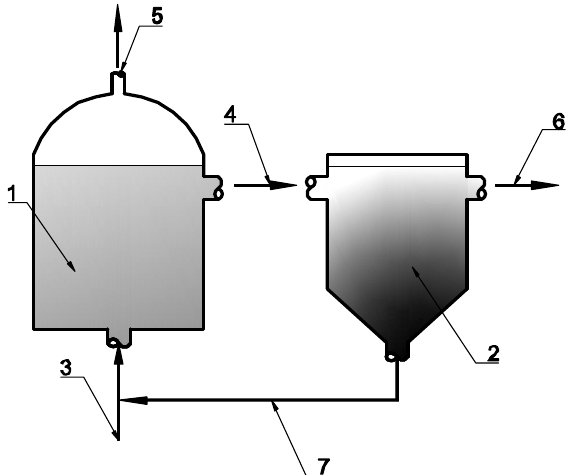
Figure 4. Diagram of a contactor: 1—reactor, 2—settlement tank, 3—raw wastewater, 4—wastewater and sludge, 5—biogas, 6—treated effluent, 7—recirculated sludge.